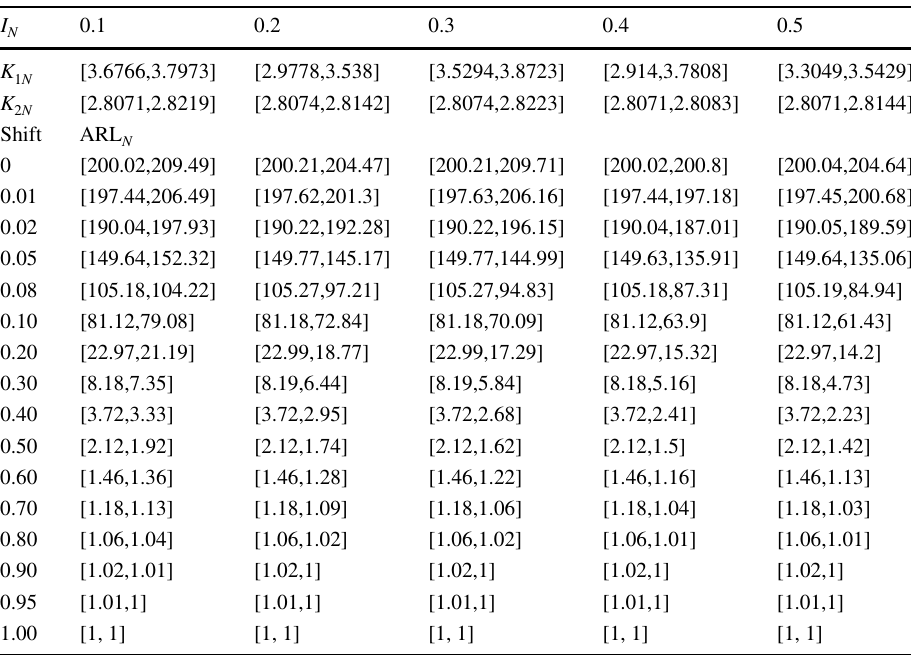
Table 4 The average run length ARL 1 values under neutrosophic statistics for n L = 30